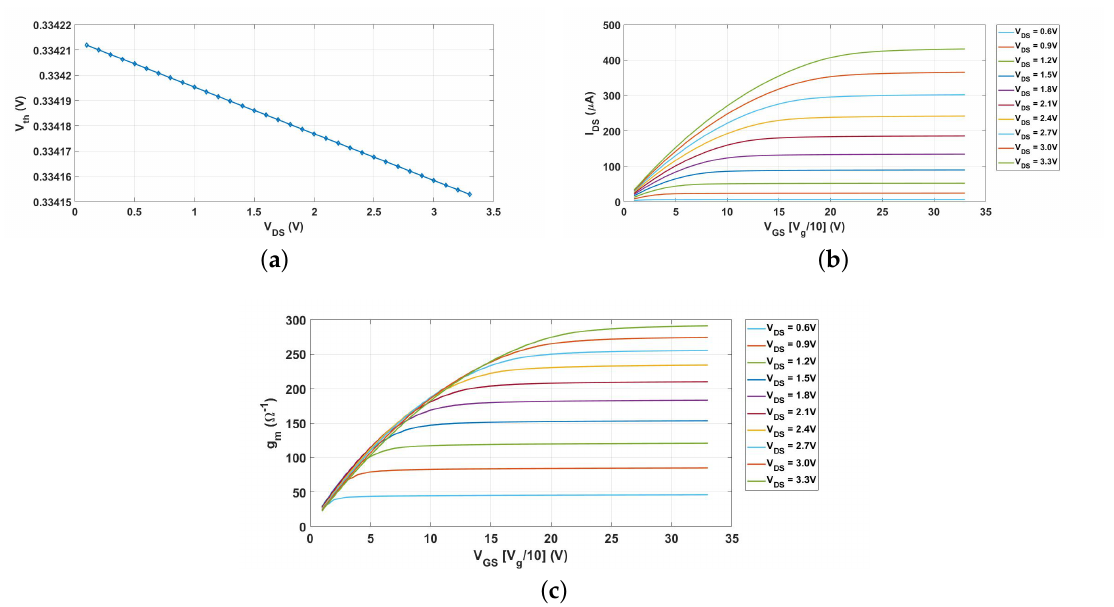
Figure 12. BSIM3v3 I-V model results. ( a ) Threshold voltage modified by drain-source and gate-source voltage, ( b ) I-V curves, and ( c ) the transistor’s transconductance for UMC0.18- µ m nMOS device.